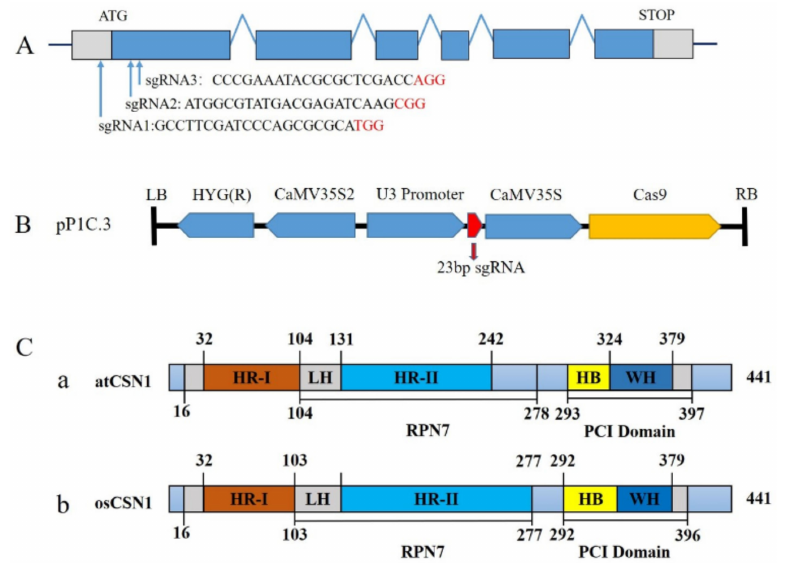
Figure 1. Schematic map of the genomic region of OsCSN1 and structure of OsCSN1. ( A ) The 20 bp sequences for sgRNA and PAM motif (NGG) are highlighted in black and red, respectively. Three target guide RNA sequences were designed in the exon1 of the OsCSN1 gene. ( B ) The structure of pP1C.3 plasmid. ( C ) Domain structure of OsCSN1 ( b ) and AtCSN1 ( a ). They have four major domains, helical repeat-I (HR-I), linker helix (LH), helical repeat-II (HR-II), and PCI Domain